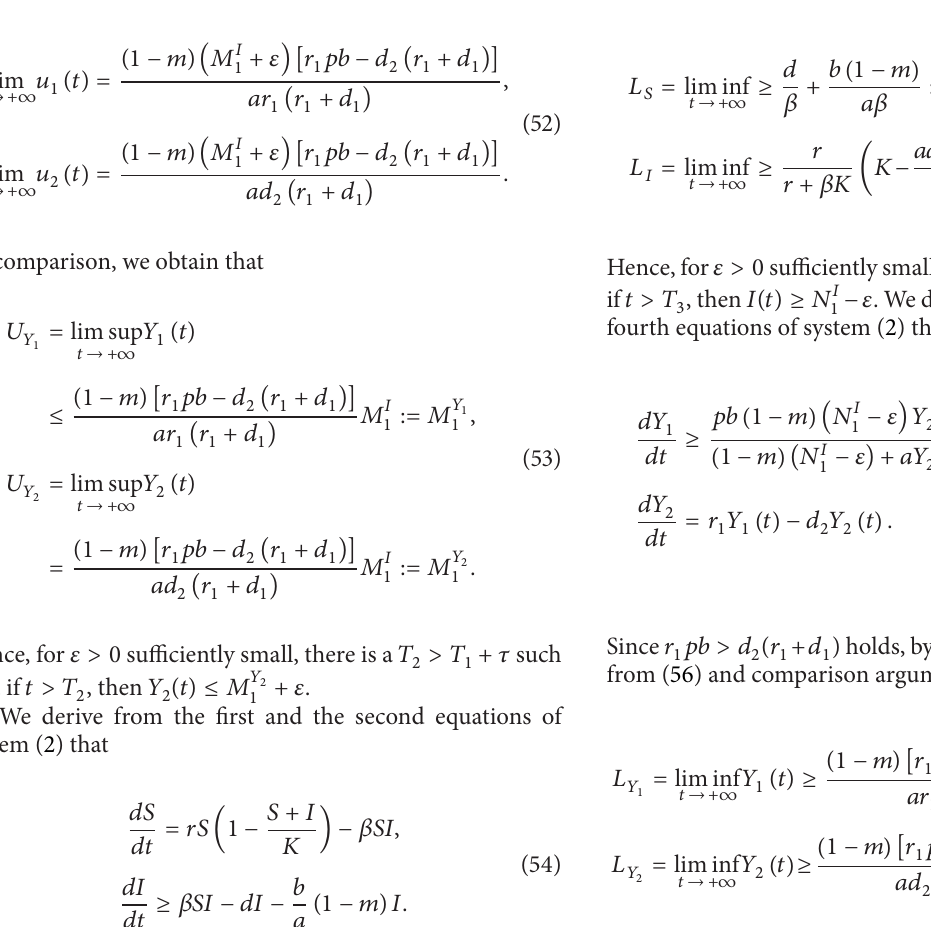
If 𝑟 1 𝑝𝑏 > 𝑑 2 (𝑟 1 + 𝑑 1 ) , then by Lemma 2.4 in [9], it